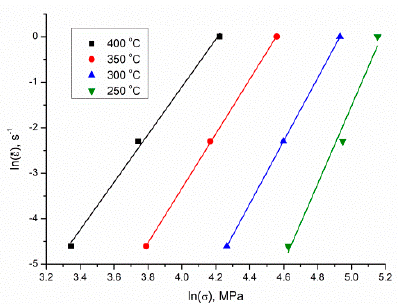
Figure 4. The relationship between ln( 𝜀(cid:4662) ) and ln( σ ).